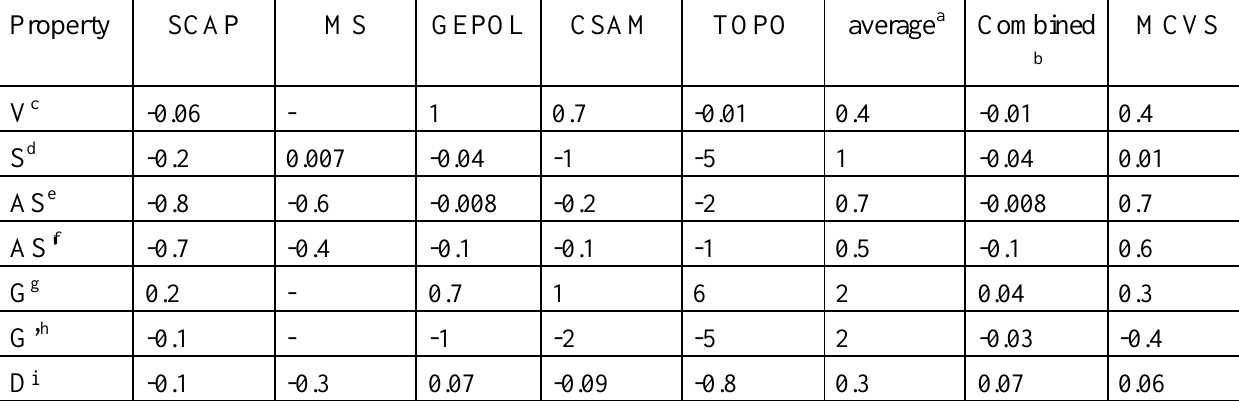
Table 3. Mean relative deviations (percent) of the geometric descriptors and topological indices for fullerene-60, -70 and -82, calculated with different cavity-free molecule methods relative to the UMCVS reference